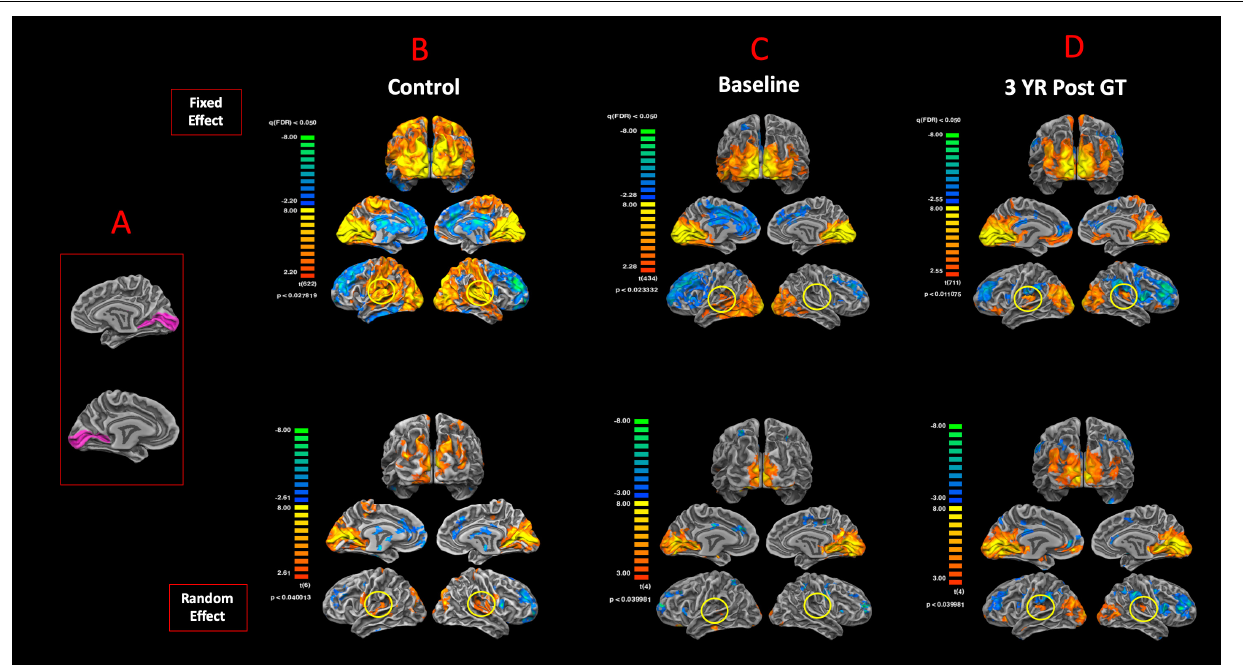
FIGURE 7 | Functional connectivity of the primary visual areas. (A) Left and right Brodmann primary visual areas (BA17) as anatomical seed points for functional connectivity analyses. Results for the FX and RFX group analyses are shown for (B) sighted controls, (C) RPE65 patients at baseline, and (D) RPE65 patients 3 years post–gene therapy. All FX group analyses were performed at FDR-corrected p < 0.02 ( q < 0.05), with an extent threshold of > 100 mm 2 , and all RFX analyses were performed at an uncorrected p < 0.04 with an extent threshold > 100 mm 2 . Sighted controls presented significant extended functional connectivity between the left and right BA17 areas and other brain regions, particularly for the primary auditory areas (circled yellow). Connectivity pattern for the RPE65 patients at baseline showed significant functional connectivity across the left and right visual cortex, but considerably reduced levels of connectivity between the primary visual and primary auditory cortices (circled yellow). However, 3 years after gene therapy, functional connectivity between the primary visual to primary auditory cortices significantly increased compared to baseline, but did not reach the same magnitude as observed in sighted controls.